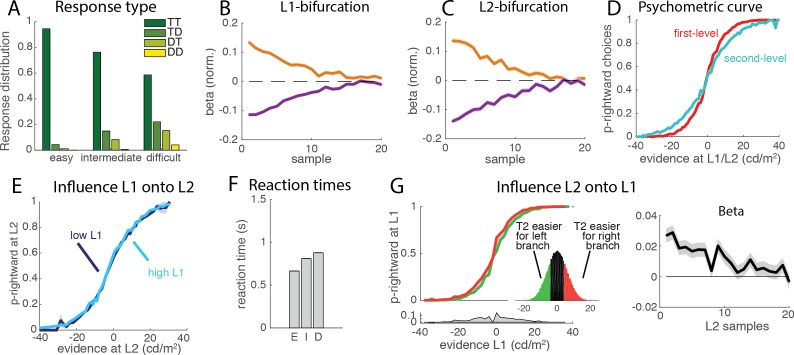
Behavioral properties of the flat race model reproduce original monkey data.The figures presented here correspond to a parameter set adjusted to reproduce reaction times (see Introduction). (A) Response type for the flat model. We simulated a simple race model with four possible options that compete for selection, based on a standard implementation of race models [Drugowitsch et al., 2014]. The histogram shows the distribution of each of the four response types (TT, TD, DT, DD) for each level of trial difficulty from simulations of the race implementation of the flat model. (B) Influence of luminance fluctuations on the L1 decisions. Weights for each of the target (orange) and distractor (blue) samples across a trial for L1 decisions, as measured with logistic regression. The model reproduces the primacy effect observed in monkey behavioural data, whereby earlier samples have larger influence on L1 choices than later samples. Shades indicating 95% confidence intervals (barely visible) are nearly collapsed to the main line. Weights have been normalized. (C) Influence of luminance fluctuations on the L2 decisions. Legend same as B. (D) Psychometric curve. The curve represents the probability that the right segment was selected at the first (L1, red curve) and second (L2, light blue curve) level depending on the strength of the evidence in favor or right vs. left path at the corresponding branching point. Steeper curve indicates better performance at the primary than secondary branches. (E) Influence of L1 difficulty onto L2 performance. Psychometric curve for L2 decision was computed separately for easy and difficult L1 trials. Unlike the flat model implemented in the original study, we find no difference in L2 performance (permutation test; p>0.4), in accordance with observed animal behavior. The null effect emerges because the minimum accumulation time before reaching a decision impedes early response even in the presence of strong evidence in L1 (see Supp. Material). When inhibition was removed, a significance interaction was recovered (Figure 2—figure supplement 1A). (F) Mean reaction times. Reaction times for the 3 types of difficulty level (E: easy. I: intermediate, D:difficult) reproduce those reported in the companion paper by Zylberberg and colleagues (Zylberberg et al., 2017). (G) Influence of L2 and L2’ difficulty onto L1 choice. Psychometric curve is plotted separately for trials where decision is easier at the left than right secondary branch (green curve), and where decision is easier at right than left secondary branch (red curve). Inset represents the distribution of difference in evidence between the two branches. The effect emerges because strong evidence at one secondary branch will bias the race towards selecting the corresponding final option, thus appearing as a bias in L1 decision towards selecting the primary branch leading to this secondary branch. Information provided at secondary branches biases choice at L1 towards selecting the branch that leads to easier secondary branch, as observed in animal behavior. Lower panel represents the difference between the two psychometric curves. (Right Panel): Influence of difficulty of L2 on the L1 decision across time, as estimated from the logistic regression. Grey shades indicate 95% confidence intervals. L1 choice is affected by difference in perceptual difficulty between L2 and L2’ branches in early visual samples.